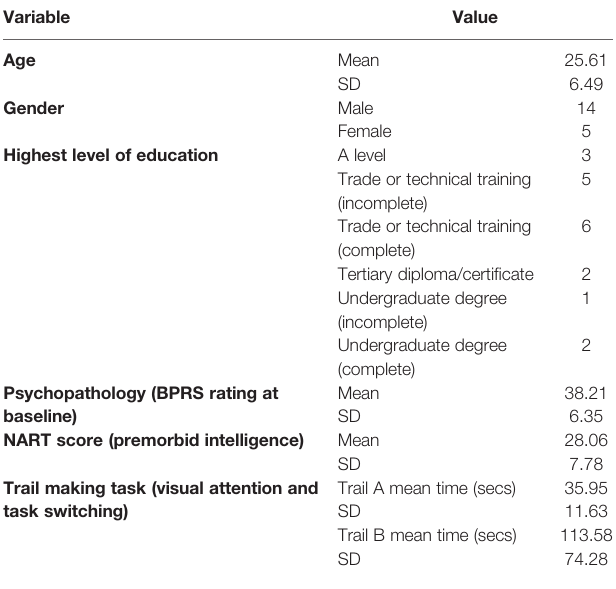
TABLE 1 | Participant demographics, psychopathology and neurocognitive measures at baseline. Variable